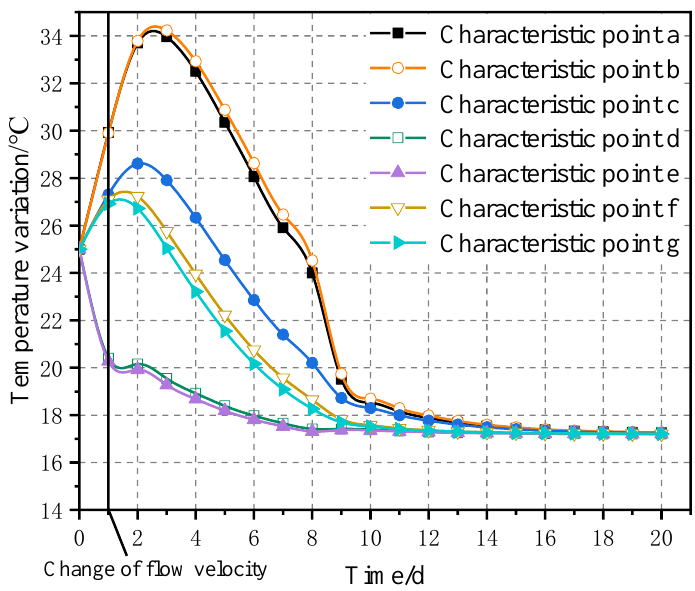
Figure 12. Temperature variation control curve.